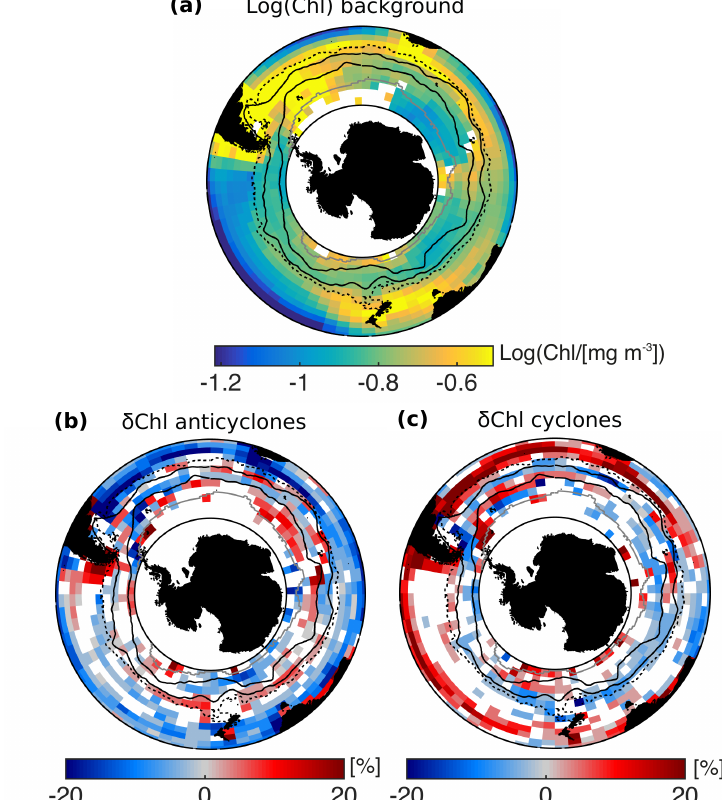
Figure 2. Spatial distribution of chlorophyll anomalies ( δ Chl) associated with eddies; (a) logarithm (base 10) of annual climatological Chl for reference, and mean δ Chl of (b) anticyclones and (c) cyclones; δ Chl is the average of anomalies of eddies lasting at least 3 weeks in 5 ◦ × 3 ◦ longitude–latitude grid boxes; white boxes indicate insufficient data (less than three data points) or anomalies insignificantly different from zero ( t test, p = 0 . 05); solid black lines mark the main branches of the ACC (the Subantarctic Front and Polar Front); the dashed black line denotes the − 20cm SSH contour and the solid gray line the northernmost extension of sea-ice cover.